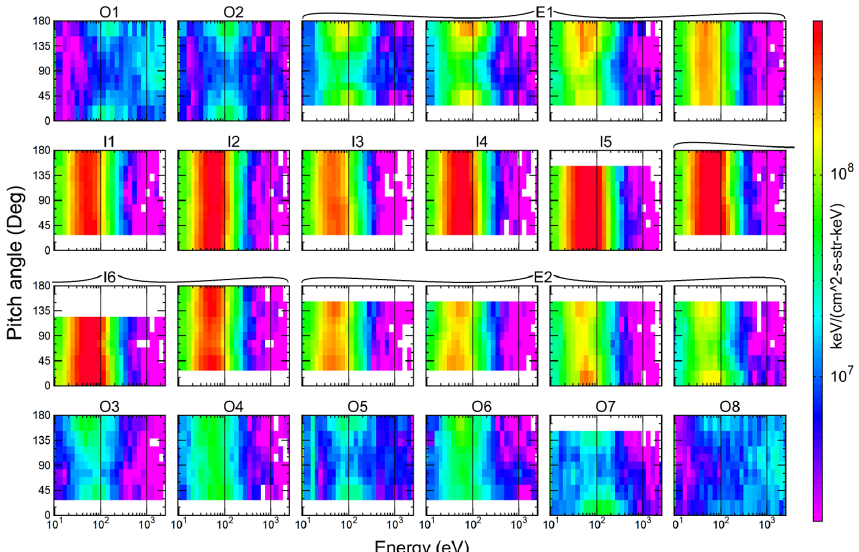
Figure 6. Individual pitch angle distributions from each layer identified in Fig. 5, in the order of observation time from top left to bottom right. The horizontal axis of each plot represents energy in eV, and the vertical axis, pitch angle in degrees. First is O 1 , where high-energy electrons disappeared around 0 and 180 ◦ pitch angle, while those in the 100eV range are enhanced at these pitch angles. O 2 plot shows higher flux for parallel and anti-parallel electrons in comparison to those which are perpendicular to the magnetic field, with a ratio of fluxes of ∼ 10. Then there are four consecutive sweeps observed during sub-interval E 1 , when the initially bidirectional distribution gradually turned into a more isotropic one, broadening first from the antiparallel direction and then spreading into the parallel beam. The next row contains the plots of I 1 to I 5 , which all show a nearly isotropic distribution of electrons, but differ in flux and energy (see Sect. 4.4.2 for details). From I 1 to I 5 the peak energy has an increasing trend, except for the central region of FTE, I 3 , which has the lowest flux and density, similar to edges E 1 and E 2 . Then, three snapshots for region I 6 are shown, where electrons perpendicular to magnetic field with energies of ∼ 73 to ∼ 142eV temporarily disappear, and the distributions become partially bidirectional. Then, there are four panels showing consecutive sweeps of observation in E 2 , where an isotropic distribution gradually turns bidirectional at the end of this sub-interval. The bottom row of plots contains snapshots outside the FTE, when the core of the FTE has been passed by the spacecraft. In O 3 the particles are nearly bidirectional. In O 4 they become more isotropically distributed. Again in O 5 the situation is very similar to O 3 which showed clearer bidirectional beams. In O 6 , the distribution is isotropic, similar to O 4 , and then again becomes more bidirectional on entering O 7 . Finally, in O 8 electrons show similar behaviour as in O 1 as high-energy electrons start to appear. Note that, due to variation of magnetic field orientation, parallel and/or anti-parallel electrons are not measured during certain intervals. (See Sect. 4.4.2 for